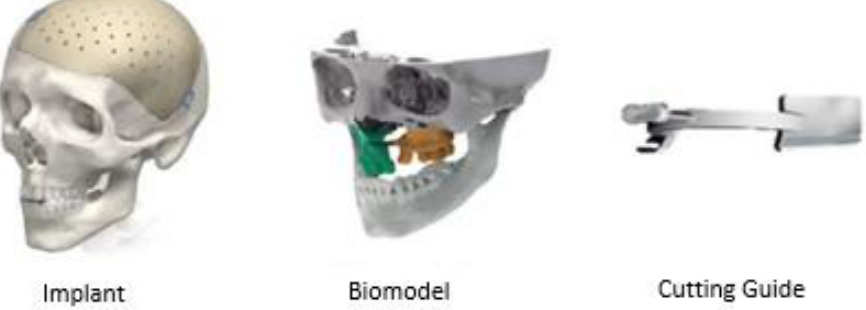
Figure 2. Categories of specific medical devices. Source: Interfaz Research Group and Grice, 2020.